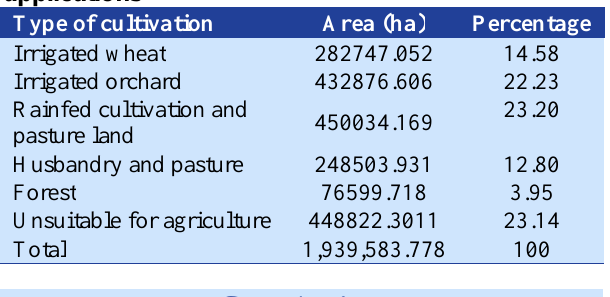
Table 3. Area of lands for various agricultural